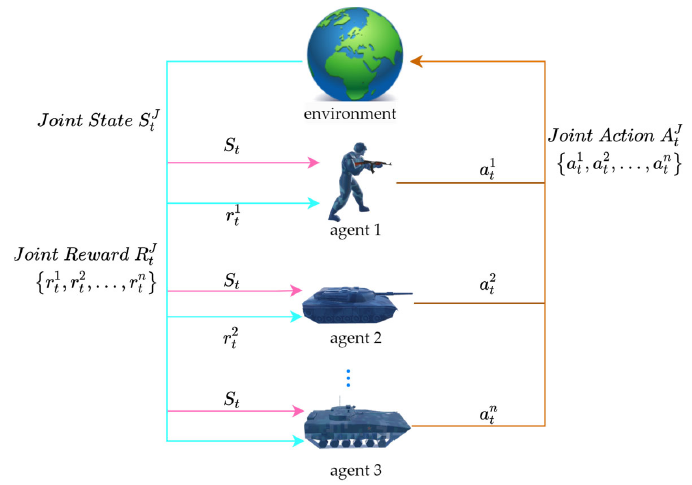
Figure 2. The MARL framework.